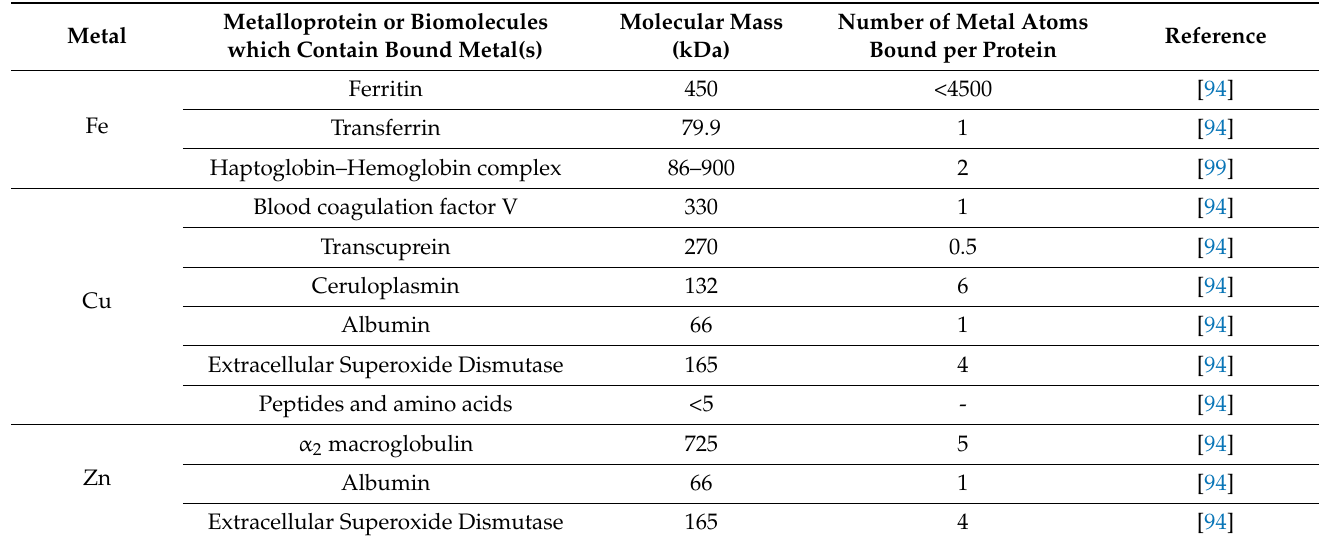
Table 1. Characteristics of major metalloproteins in human plasma.